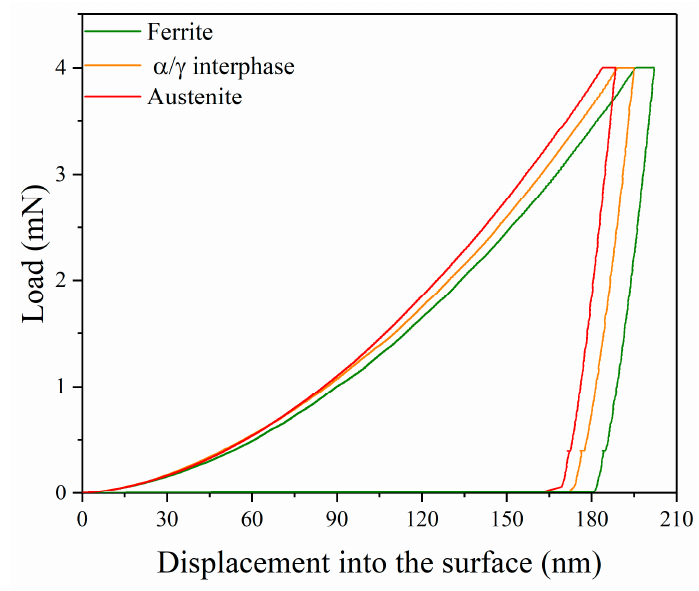
Figure 10. Load-displacement curves obtained from different imprints performed on austenite, ferrite and interphase.